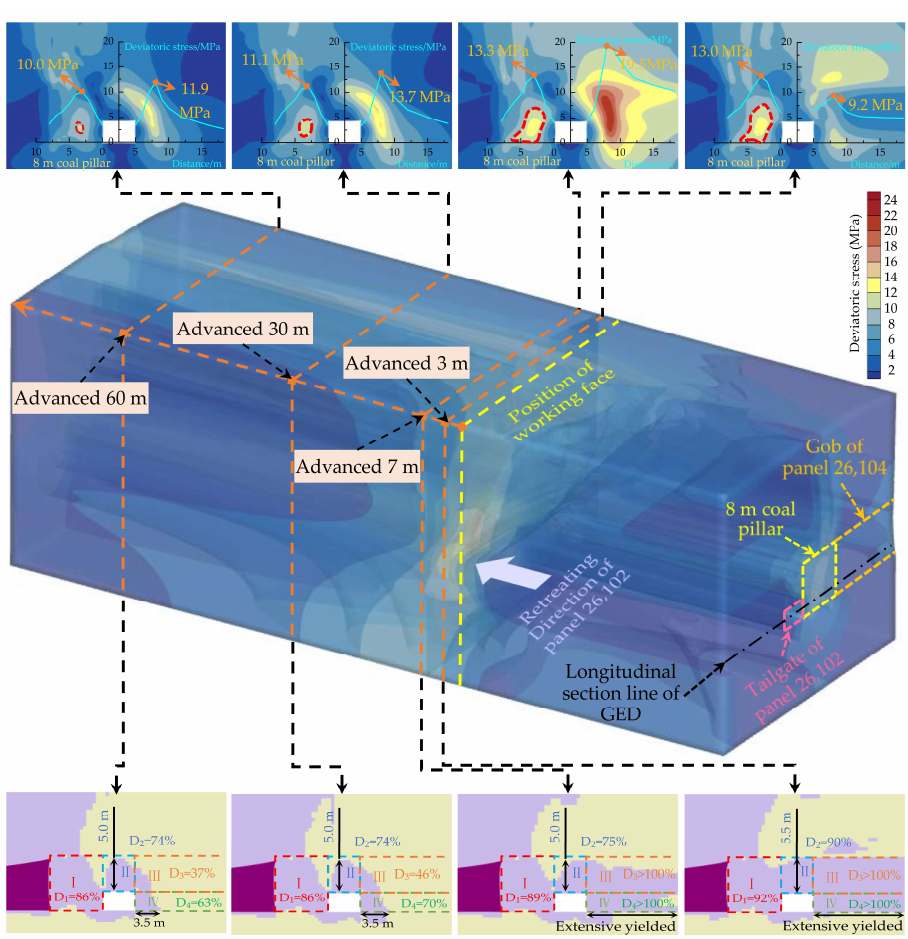
Figure 10. The distribution characteristics of surrounding rock advanced of the working face.